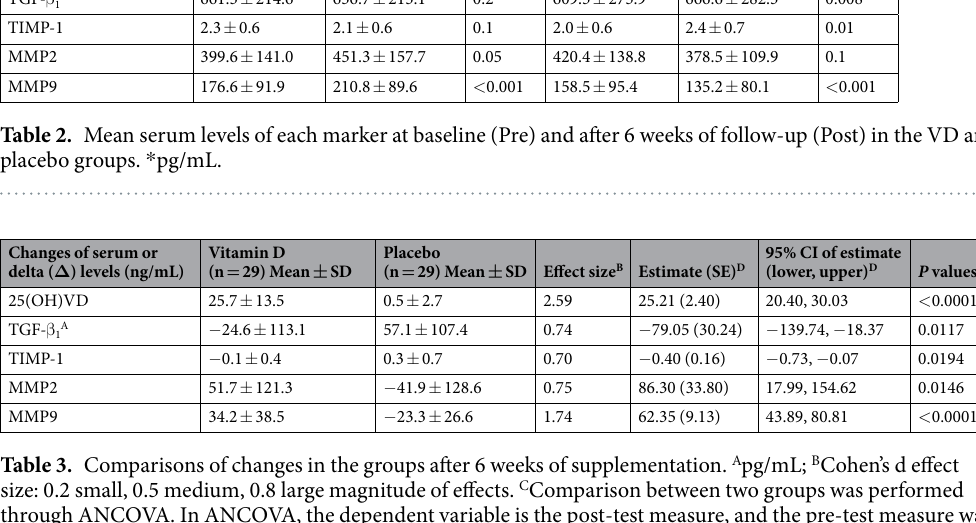
Table 3. Comparisons of changes in the groups after 6 weeks of supplementation. A pg/mL; B Cohen’s d effect size: 0.2 small, 0.5 medium, 0.8 large magnitude of effects. C Comparison between two groups was performed through ANCOVA. In ANCOVA, the dependent variable is the post-test measure, and the pre-test measure was a covariate and controlled for. And also controlled were cirrhosis, gender and genotype status. D Estimate is the adjusted difference between treatment and placebo group (pre-test measure was adjusted